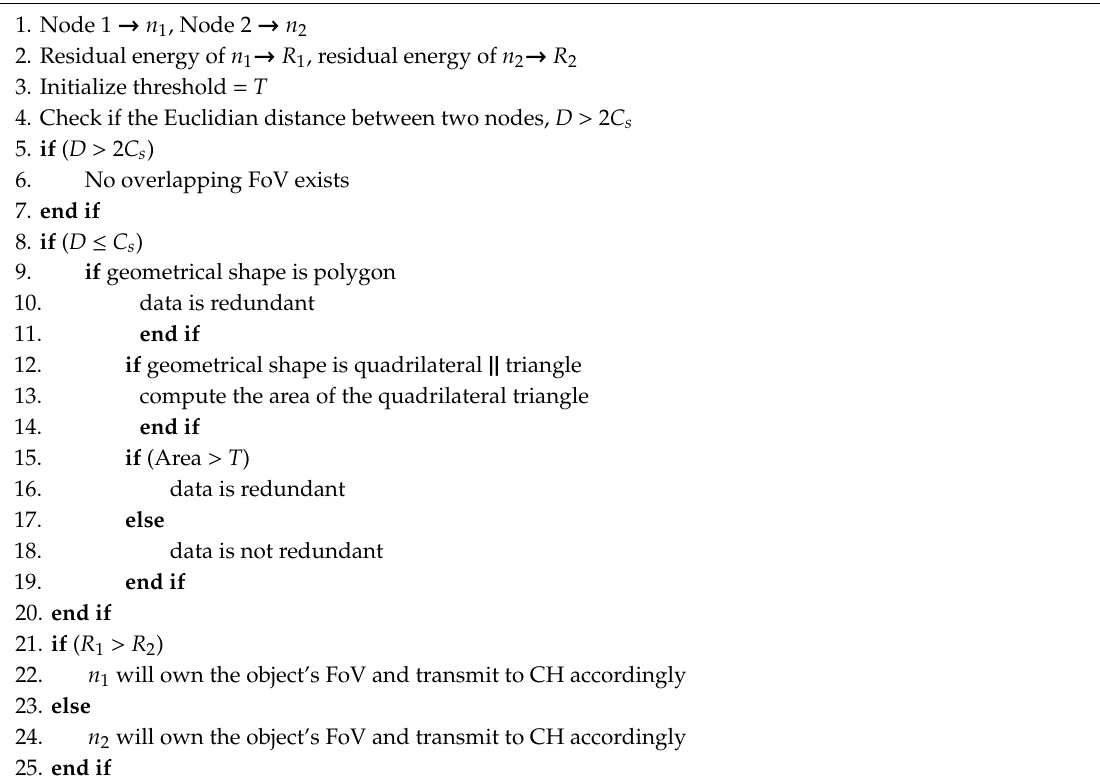
Algorithm 1 Data redundancy avoidance